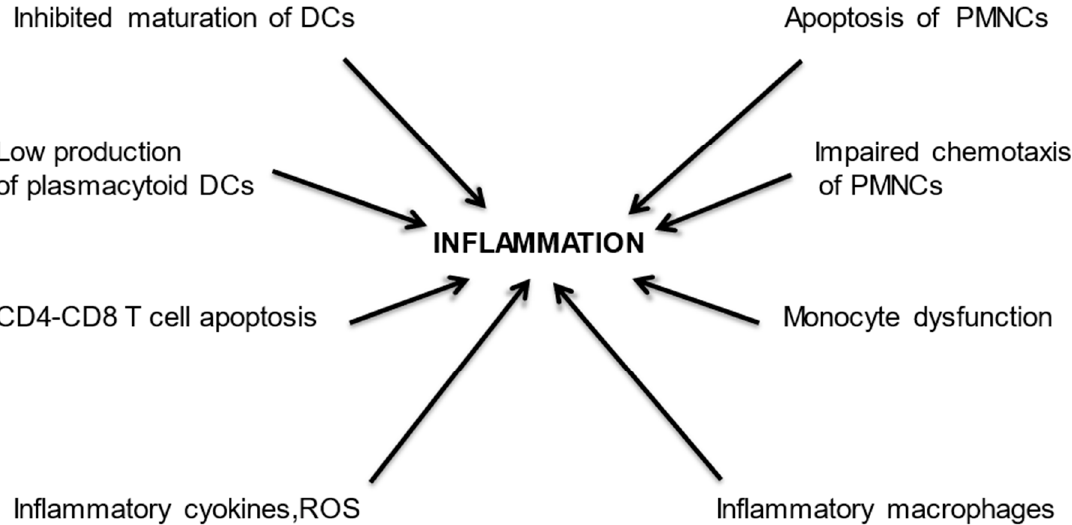
Figure 1. Accumulation of uraemic toxins can lead to depletion and dysfunction of dendritic cells (DCs), polymorphonuclear cells (PMNCs), and monocytes, eventually resulting in an inflammatory state. In addition, uraemic toxins can cause apoptosis of effector T cells, which stimulates the pro ‐ duction of inflammatory cytokines and reactive oxygen species (ROS), further increasing inflamma ‐ tion.